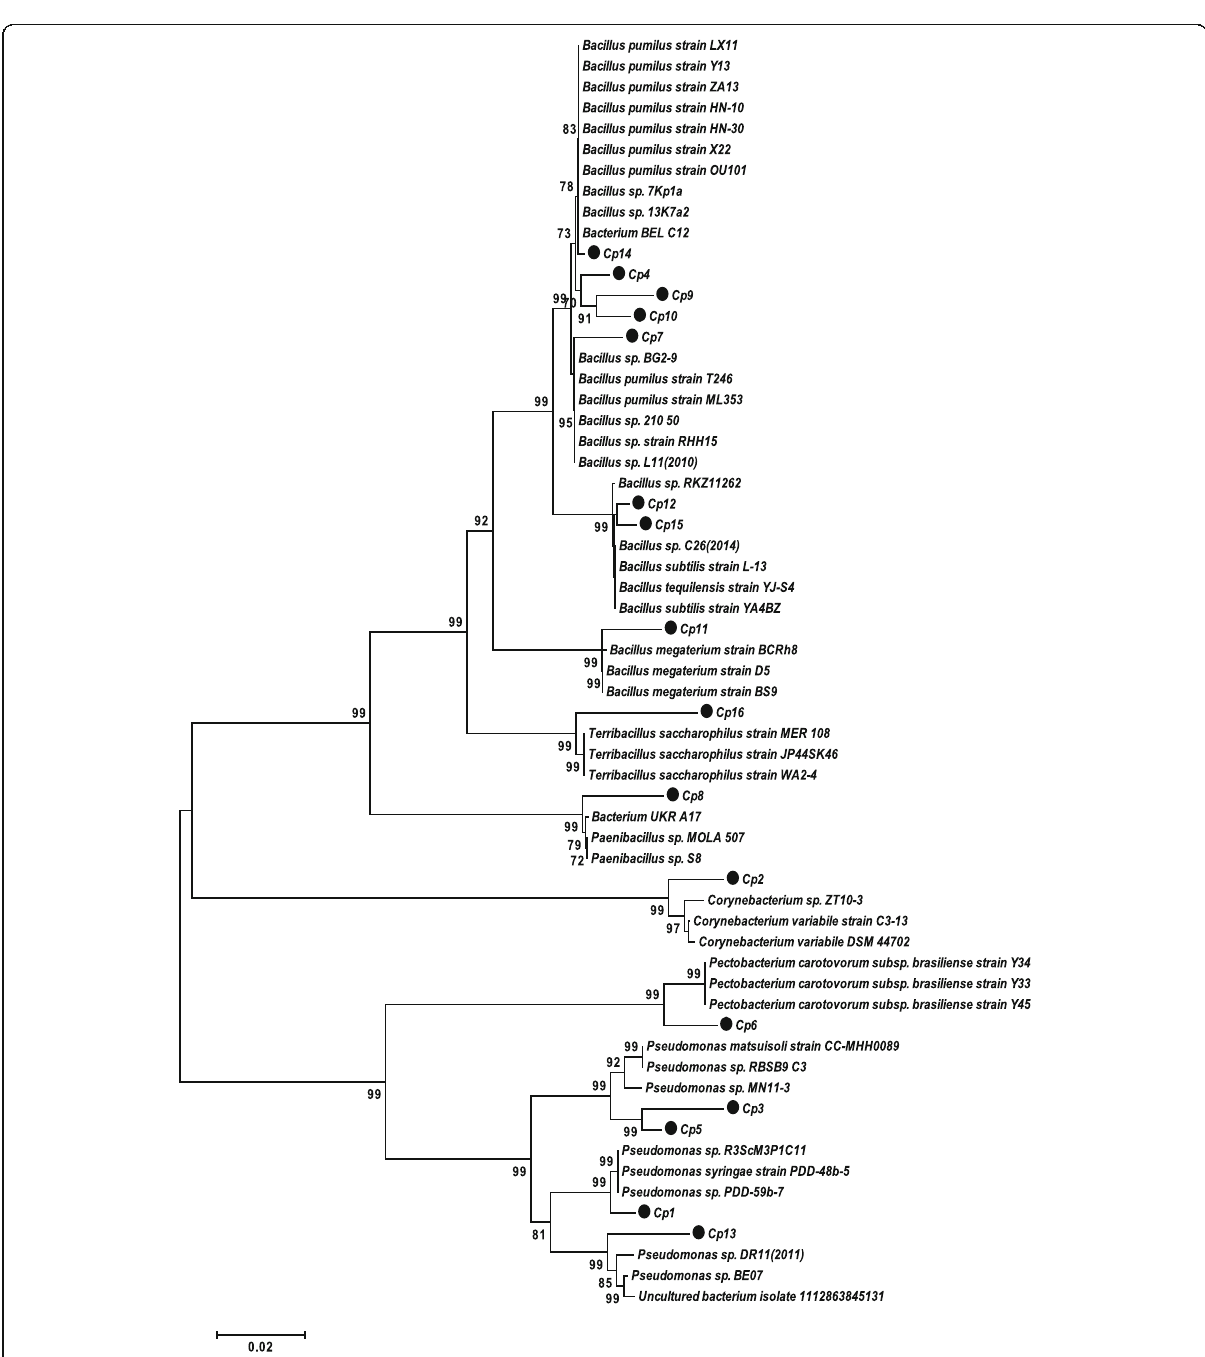
Fig. 1 Phylogenetic tree derived from neighbor-joining analysis of 16S rRNA sequences (1400 bp) from the flora members of C. pomonella and their closely related species. Bootstrap values based on 1000 replicates were indicated above nodes. Bootstrap values C ≥ 70 are labeled. C. pomonella isolates were indicated with black circle. The scale on the bottom of the dendrogram indicates the degree of